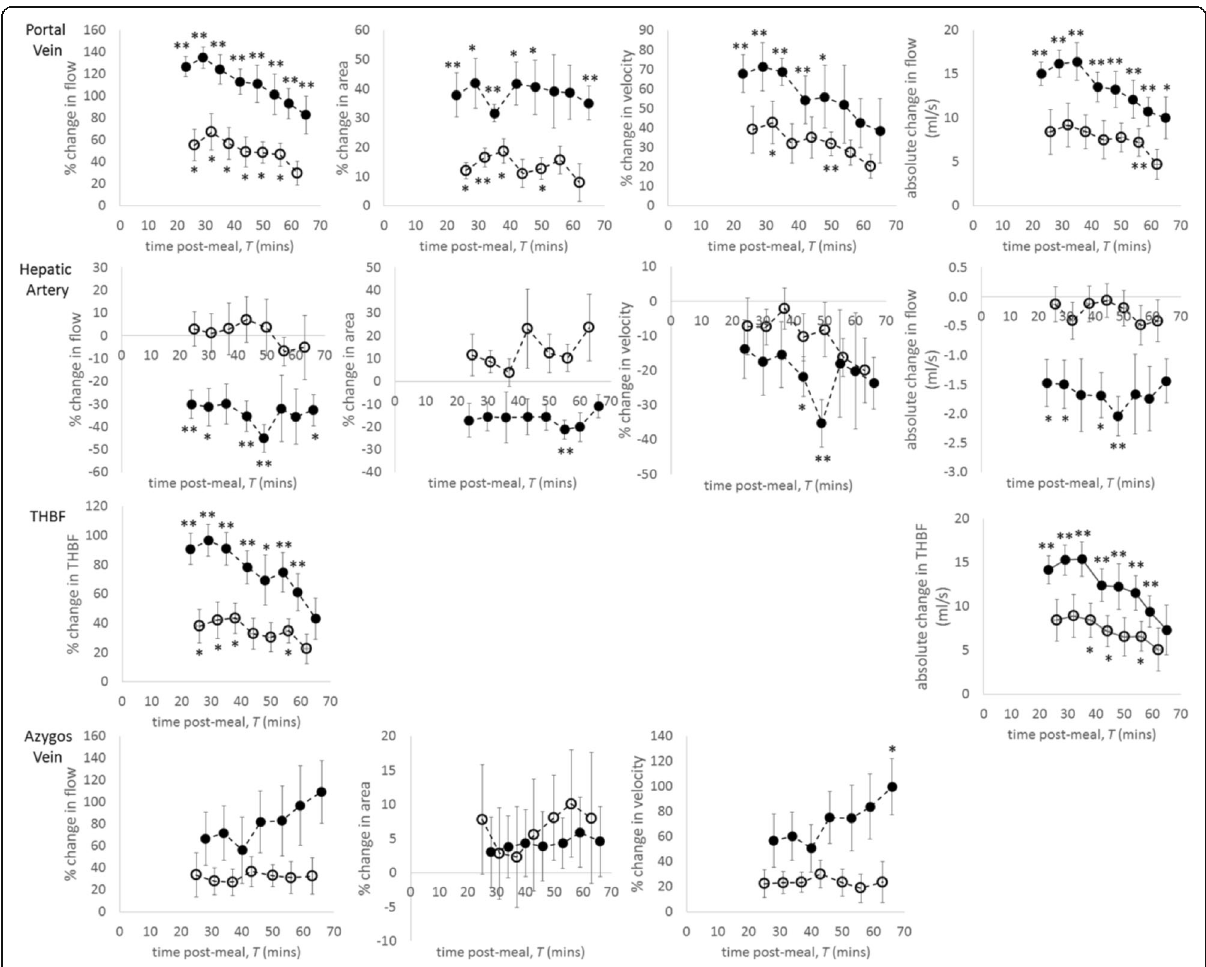
Fig. 4 Percentage change in flow, area and velocity in the portal vein, hepatic artery, total hepatic blood flow (THBF) and azygos vein following meal ingestion in healthy participants and patients with compensated cirrhosis (mean ± standard error of the mean). Absolute change in flow is also given. Filled circles indicate healthy participants and open circles indicate patients with compensated cirrhosis. Comparison of each time point with baseline, * p < 0.05, ** p < 0.01. T